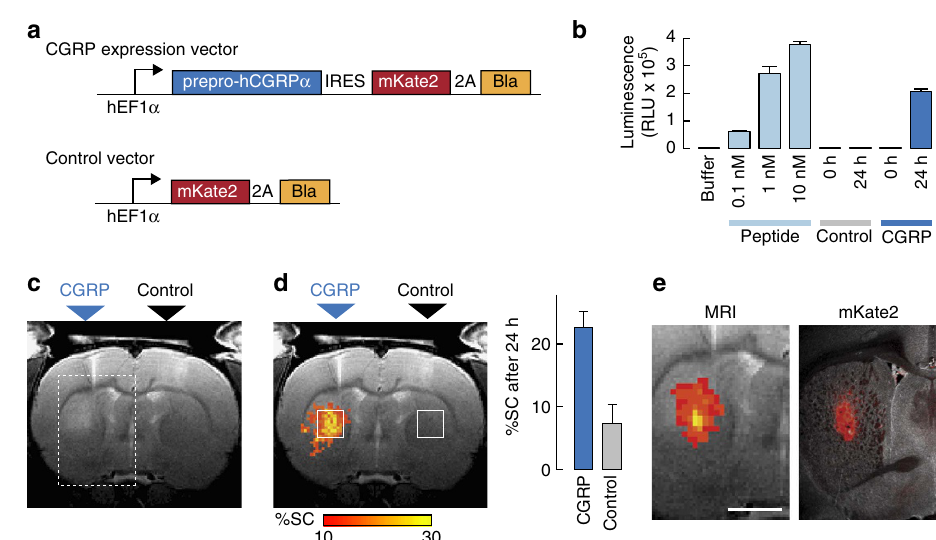
Figure 4 | Application of CGRP as a genetically expressed vasoactive reporter. ( a ) Lentiviral vectors were used for expression of prepro-CGRP or a control construct. Top: probe vector controlled by the hEF1 a promoter, encoding human prepro-CGRP (prepro-hCGRP a ), an internal ribosome entry site (IRES), and the red fluorescent protein mKate2 joined by a self-cleaving viral 2A peptide to the blasticidin selection marker (Bla). Bottom: control vector lacking prepro-hCGRP a and the IRES sequence. ( b ) In vitro demonstration of substantial CGRP release from transfected HEK293FT cells. RAMP1/CLR activation by aliquots of purified CGRP peptide (light blue) or supernatants from cultured cells expressing control (grey) and prepro-CGRP (dark blue)